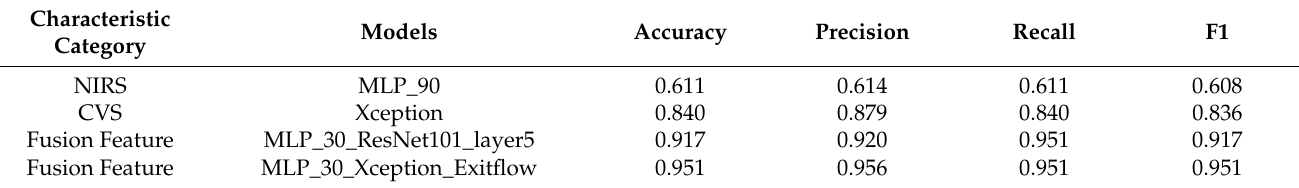
Table 7. Results of the optimal model built with different features on the validation set.